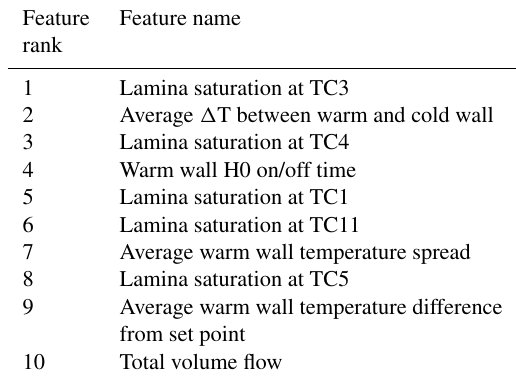
Table 1. List of the ten most important features from the RFR. TC corresponds to thermocouple and H to heater (supplemental heat- ing is used to maintain wall isothermality in the SPIN chamber) where numbers correspond to locations described in Garimella et al. (2016). Lamina saturation is calculated at specific locations us- ing temperature measurements and assuming walls exist at ice sat- uration per the method outlined in Garimella et al. (2016). The fea- tures are predominantly located in the top and middle sections of the